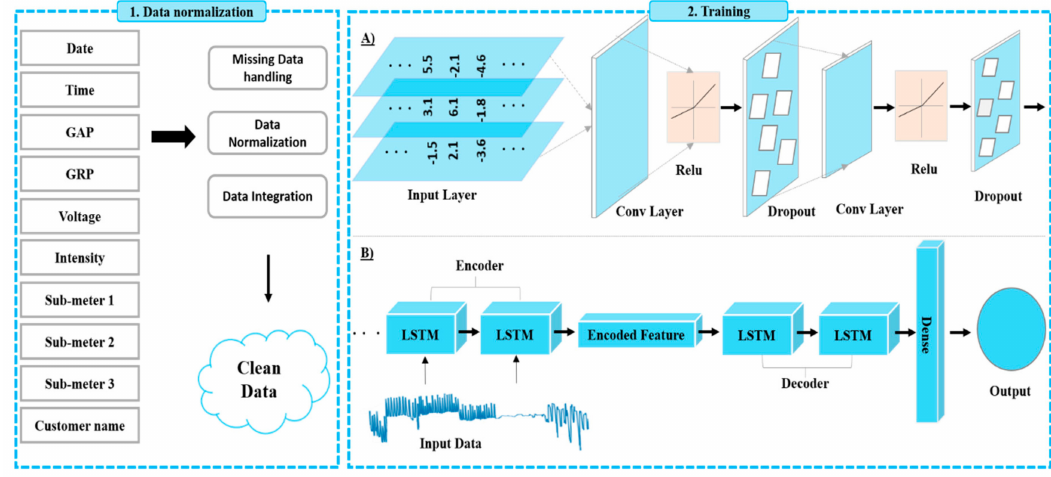
Figure 1. Proposed framework for electricity consumption